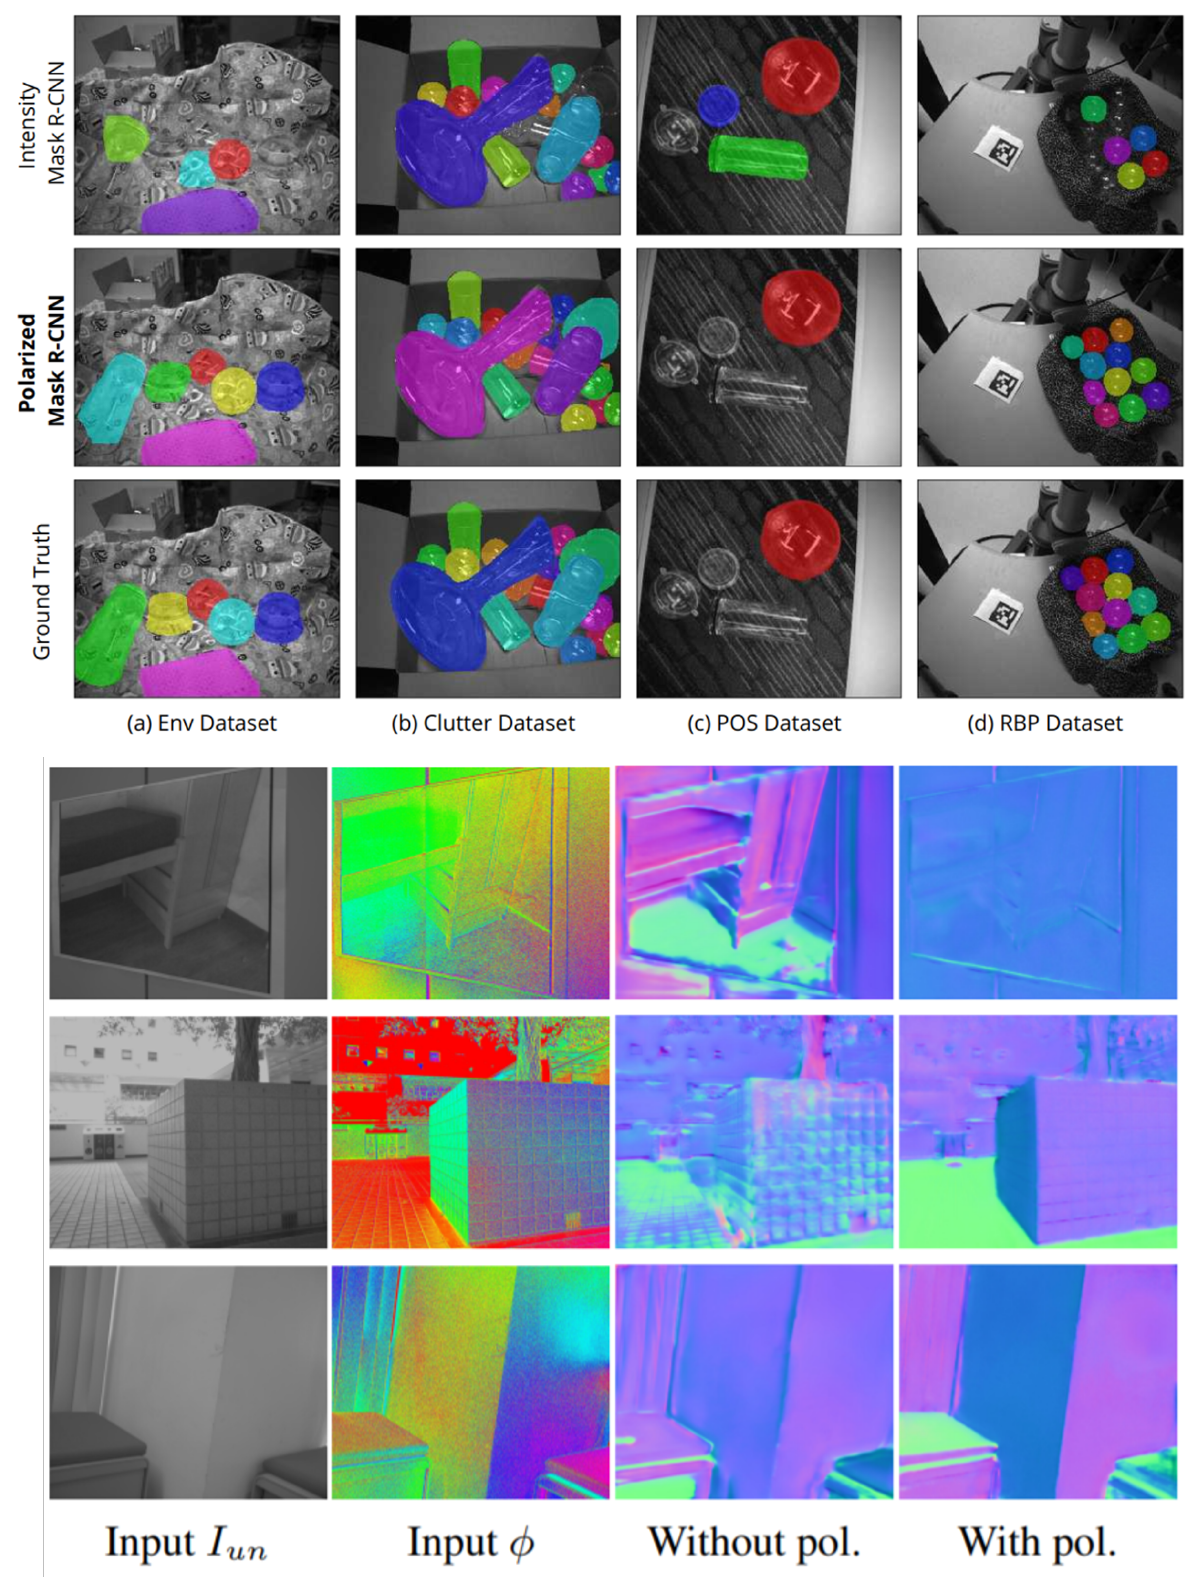
Figure 28. ( Top ) Qualitative comparisons [305]. ( Bottom ) 1st row: polarization provides geometry cues. 2nd and 3rd rows: polarization provides guidance for planes with different surface normal. I un : unpolarized data; φ : AoP